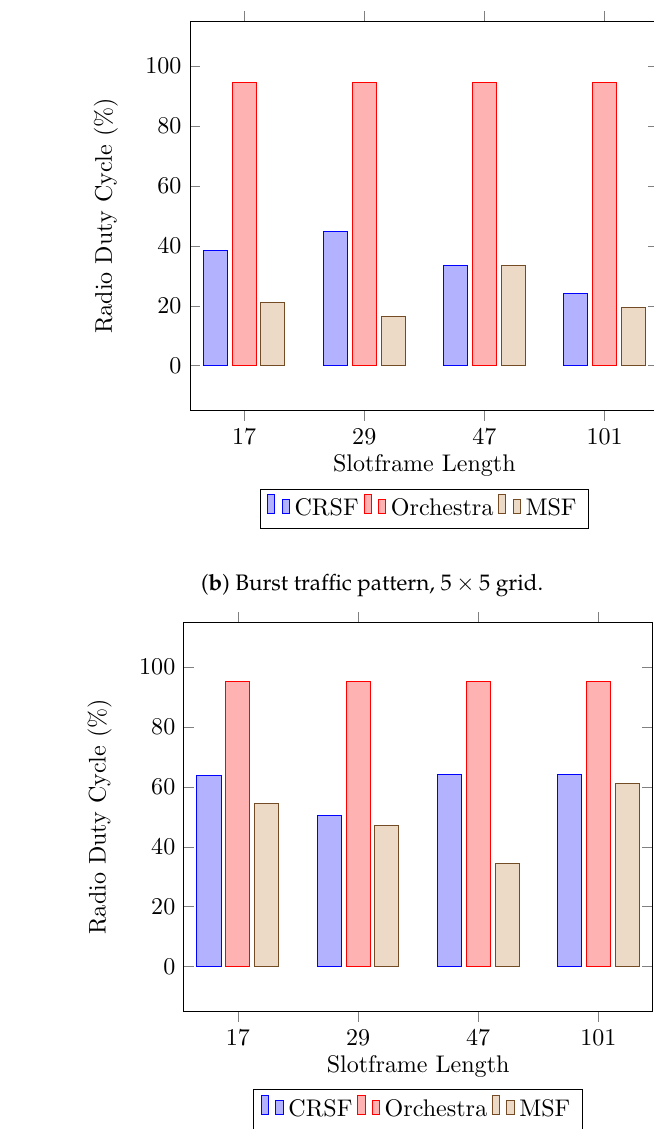
( a ) Burst traffic pattern, 4 × 4 grid. ( b ) Burst traffic pattern, 5 × 5 grid.